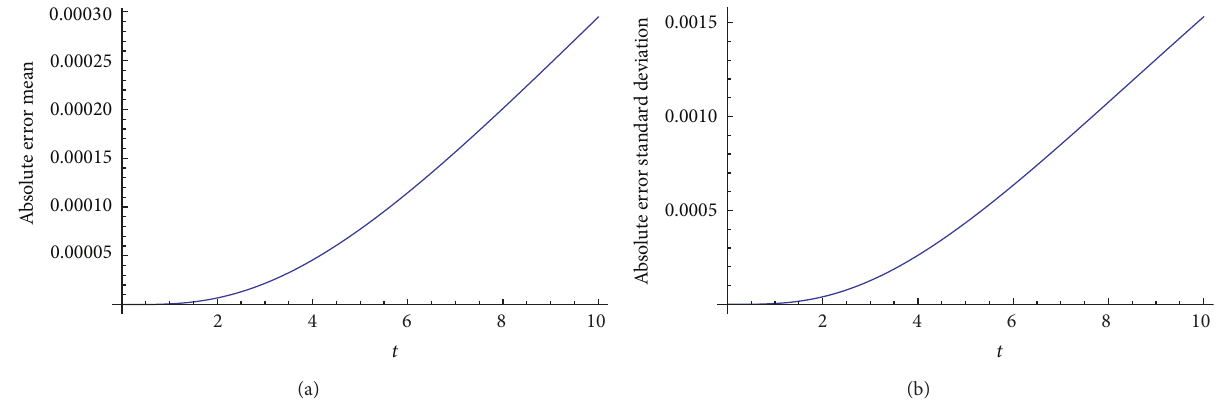
Figure 4: Absolute errors of the approximation to the expectation (a) and standard deviation (b) of the solution s.p. 𝑦(𝑡) on the interval [0,10] in Example 2. (a) Expectations. (b) Standard deviation.